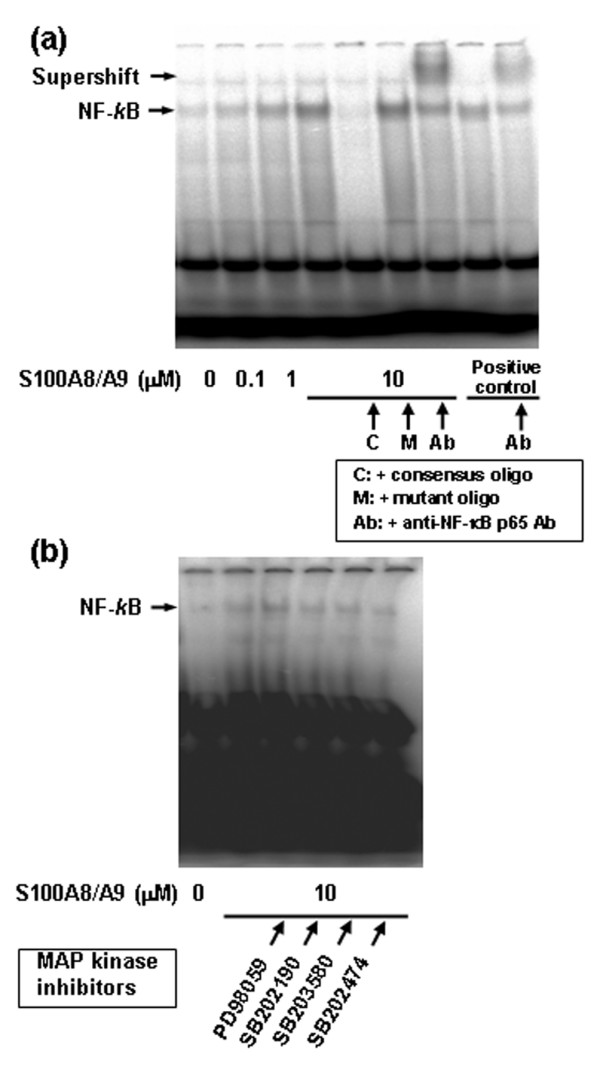
S100A8/A9-induced nuclear factor kappa B (NF-κB) activation and its independence of p38 mitogen-activated protein kinase (MAPK) activation. (a) Activation of the transcriptional factor NF-κB in S100A8/A9-stimulated monocytes. Monocytes (1 × 106 cells per ml in culture medium with 1% fetal calf serum) were stimulated for 30 minutes with or without S100A8/A9 (0.1–10 μM) in the presence of polymyxin B (100 μg/ml). Nuclear proteins were extracted from the cells, and electophoretic mobility shift assay (EMSA) was performed, as described in Materials and methods. Nuclear proteins prepared from monocytes stimulated with 100 ng/ml of lipopolysaccharide were used as positive controls. The specificity of NF-κB protein binding was verified by inhibition and supershift experiments with unlabeled NF-κB consensus or mutant oligonucleotides and anti-NF-κB p65 antibody. (b) Effects of p38 MAPK inhibition on S100A8/A9-induced NF-κB activation. Monocytes, after two-hour pretreatment with or without the MAPK inhibitors (PD98059, SB202190, and SB203580) and the control compound SB202474, were stimulated for 30 minutes with or without S100A8/A9 (10 μM), and nuclear proteins were prepared. The DNA-binding activity of NF-κB was determined by EMSA.